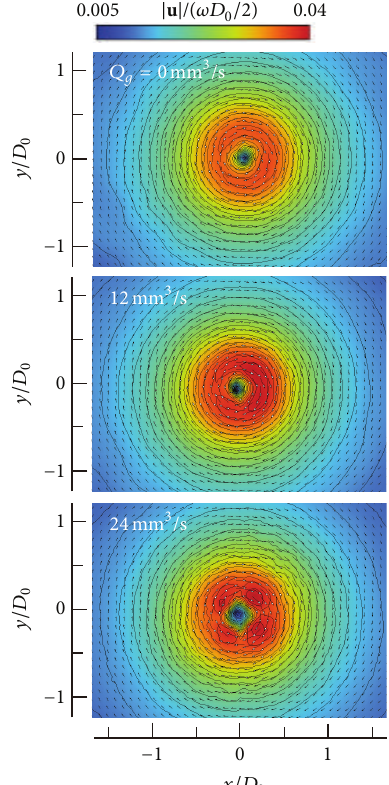
Figure 11: Change in water velocity due to bubbles at 𝑧/𝐷 0 = 4.17 when Ω = 7.9 × 10 4 .